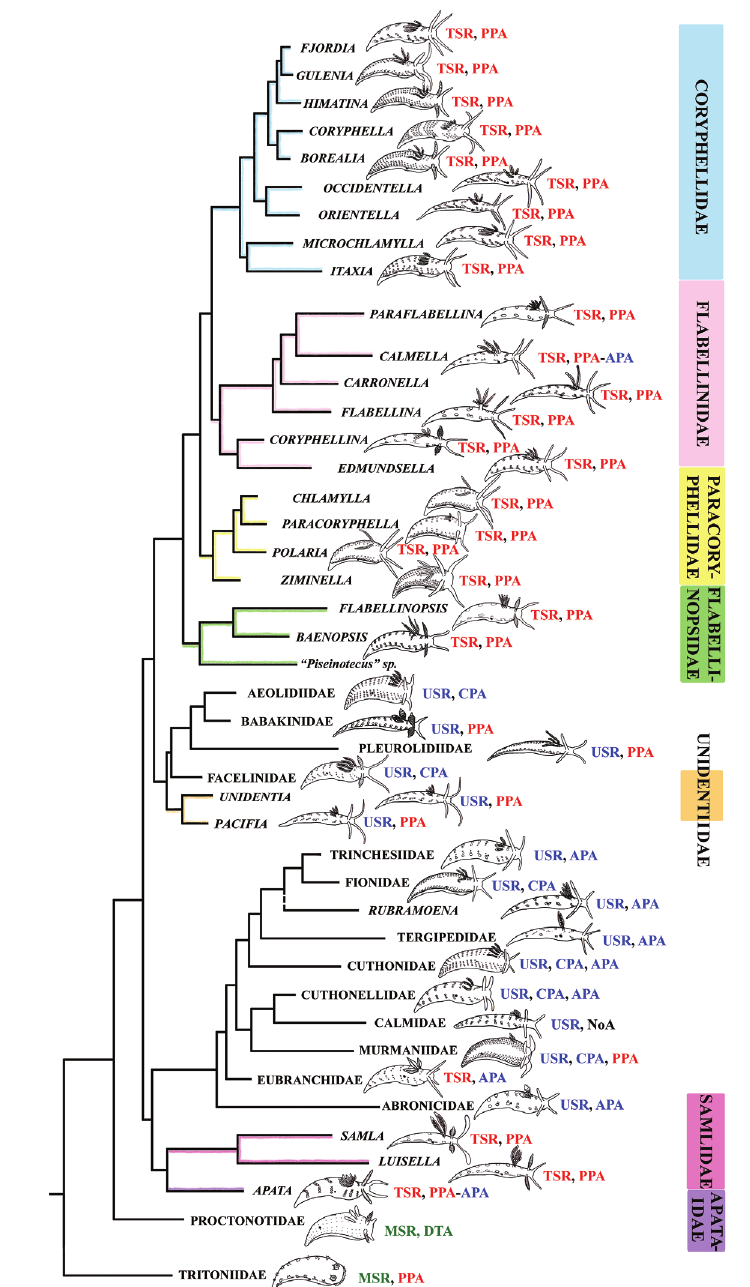
Figure 2. Phylogenetic tree of aeolids with integrated data on external morphology. The “Flabellinidae” polyphyletic family complex is highlighted by different colours; names of the family- and genus-level taxa are provided. Abbreviations: CPA cleioproctic anus APA acleioproctic anus DTA dorso-terminal anus MSR multiserial radula PPA pleuroproctic anus TSR triserial radula USR uniserial